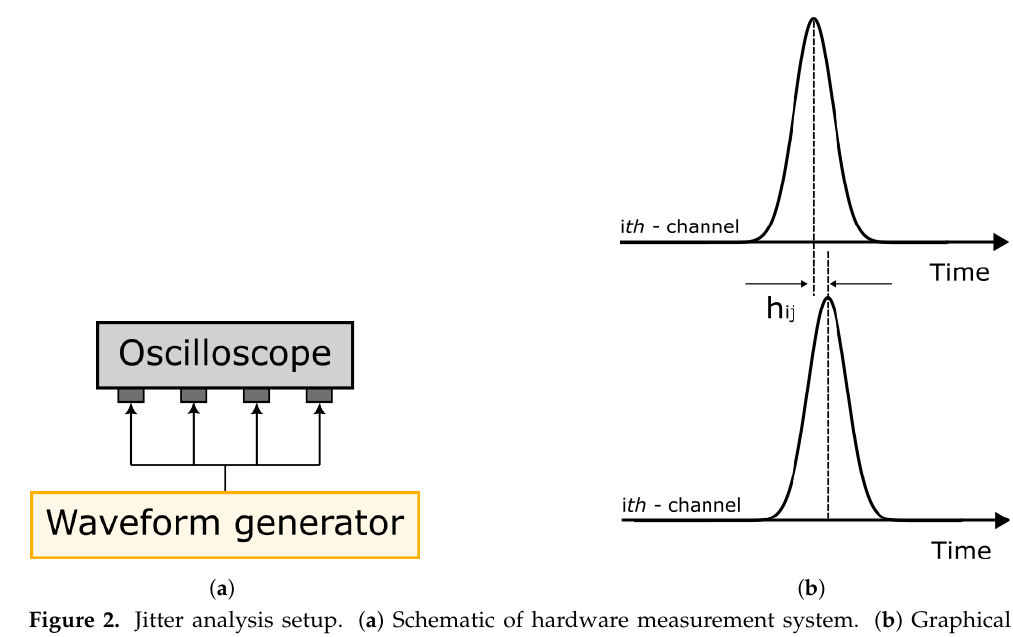
Figure 2. Jitter analysis setup. ( a ) Schematic of hardware measurement system. ( b ) Graphical definition of jitter analysis.